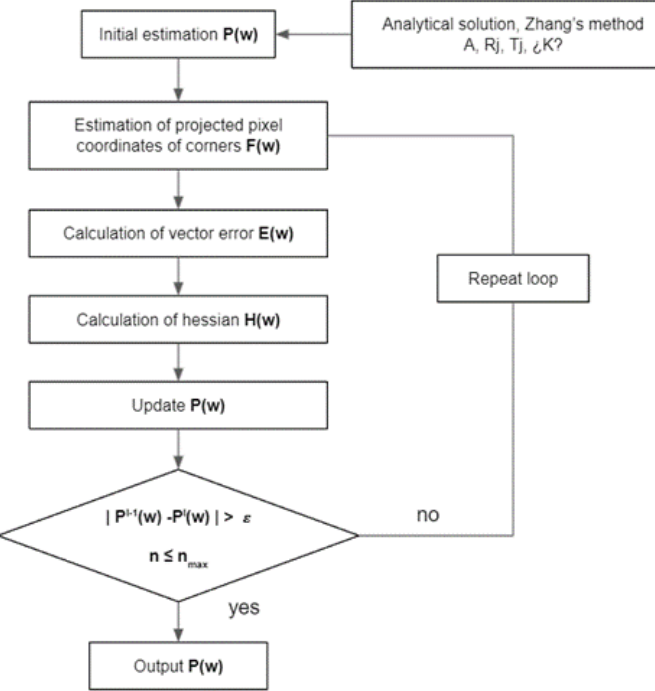
Figure A1. Iterative refinement of single‑camera